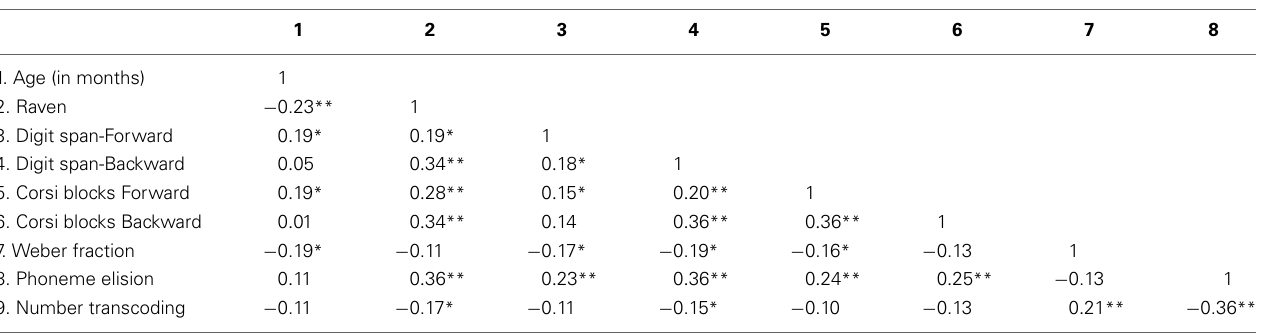
Table 1 | Correlation